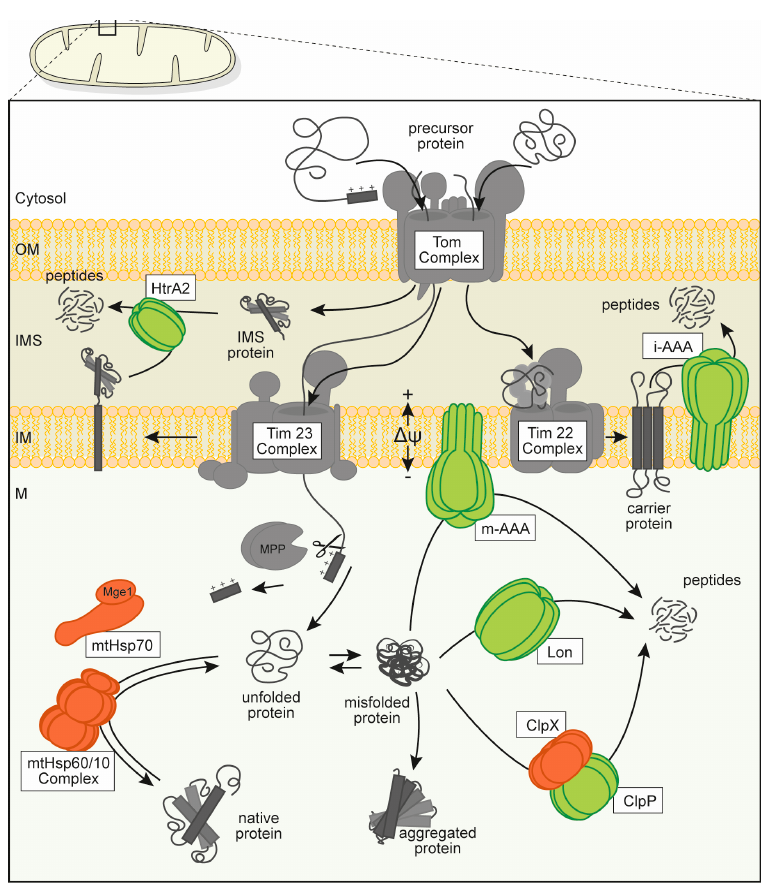
Figure 1. Overview over the mitochondrial protein quality control (PQC) system consisting of several types of molecular chaperones (orange) and oligomeric, chambered proteases (green). Proteins are depicted in a schematic form (not to scale) that is roughly based on available structural data. Mitochondrial protein biogenesis relies on the import of cytosolically synthesized preproteins through the mitochondrial outer and inner membranes via dedicated translocation pores (gray). Proteins translocated into the matrix compartment are usually processed to the mature form and require folding and assembly to their active conformation under assistance of molecular chaperones. Misfolded or denatured polypeptides are also recognized and stabilized by interaction with chaperone enzymes but may be degraded to avoid accumulation of protein aggregates. Abbreviations: mitochondrial membrane potential ( ∆ ψ ), outer membrane (OM), intermembrane space (IMS), inner membrane (IM) and mitochondrial matrix (M), translocase of the inner membrane, mitochondrial (Tim complex), translocase of the outer membrane, mitochondrial (Tom complex), mitochondrial-processing peptidase (MPP), high temperature requirement protein A2 (HtrA2), intermembrane space AAA protease (i-AAA), matrix AAA protease (m-AAA), genome maintenance exonuclease 1, mitochondrial (Mge1), heat shock protein 70 kDa, mitochondrial (mtHSP70), complex of heat shock protein 60 kDa and 10 kDa, mitochondrial (mtHsp60 / 10 complex), ATP-dependent Clp protease ATP-binding subunit